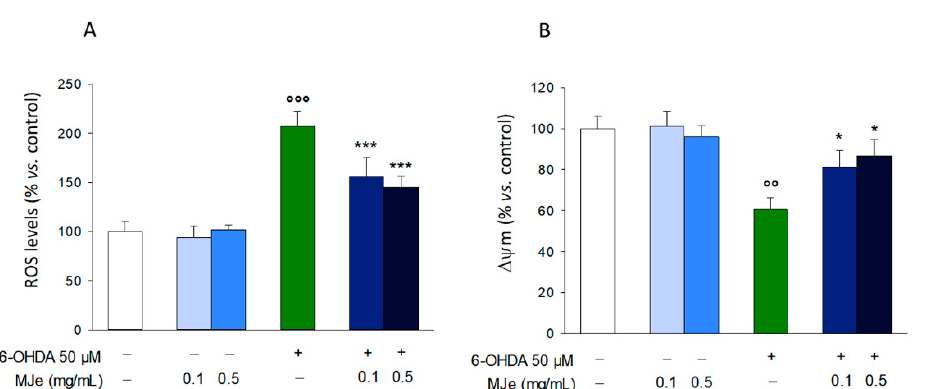
Figure 6. MJe diminished both generation of reactive oxygen species (ROS) and fall of mitochondrial membrane potential ( ∆Ψ m) induced by 6-OHDA. ( A ) ROS accumulation was measured using the fluorescent probe DCFH-DA. ( B) ∆Ψ m was assessed using the cationic fluorochrome R123. Results are reported as percentage of the levels detected in untreated cells. Data are displayed as the mean ± SEM of three experiments in triplicate (N = 9). ◦◦ p < 0.01 and ◦◦◦ p < 0.001 vs. ctrl; * p < 0.05 and *** p < 0.001 vs. 6-OHDA 50 µ M.